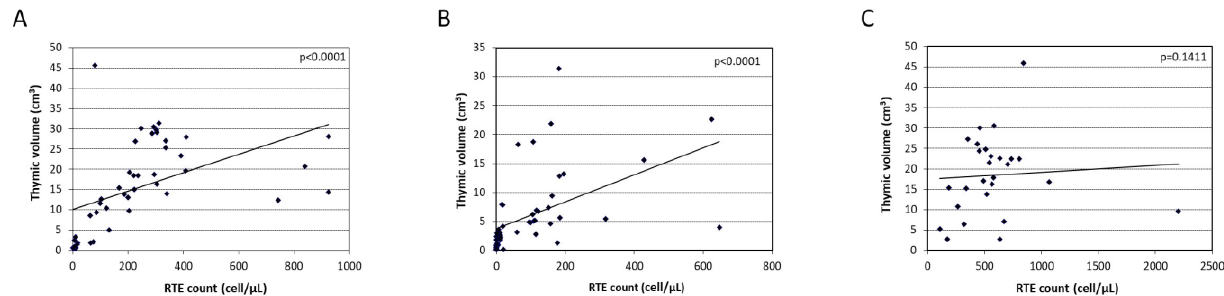
Figure 5. Python scatter plot of correlation between thymic volume (cm 3 ) and recent thymic emigrant count (cell/μL) at 1-year post-transplantation. ( A ) Thymic volume and recent thymic emigrant count correlation in the low ATG/lymphocyte ratio group. ( B ) Thymic volume and recent thymic emigrant count correlation in the high ATG/lymphocyte ratio group. ( C ) Thymic volume and recent thymic emigrant count correlation in the ATG-unexposed group.